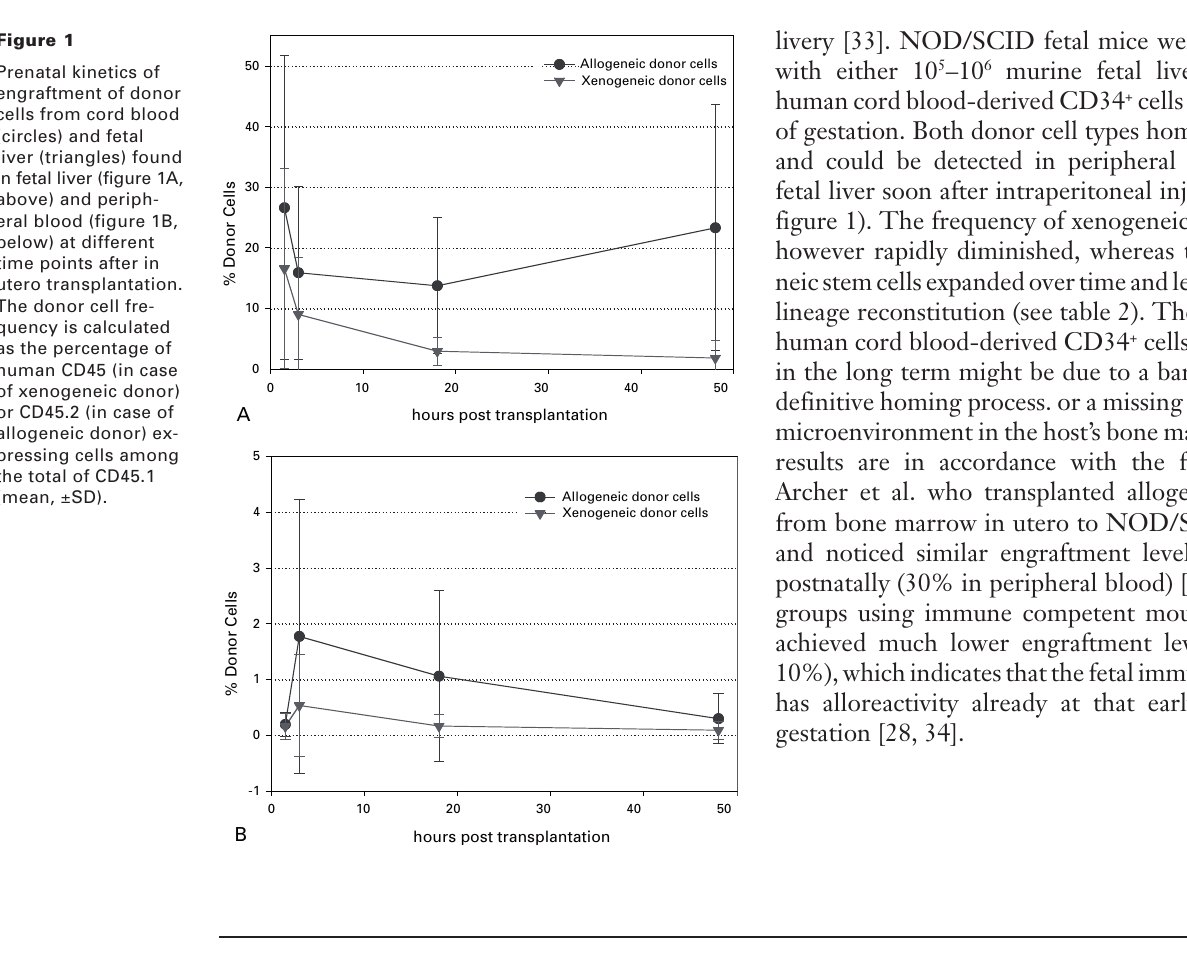
Postnatal long-term engraftment levels of allogeneic donor cells in peripheral blood, bone marrow and spleen of NOD/SCID mice at various time points (n = number of sam- ples, SD = standard deviation, na = not assessed).